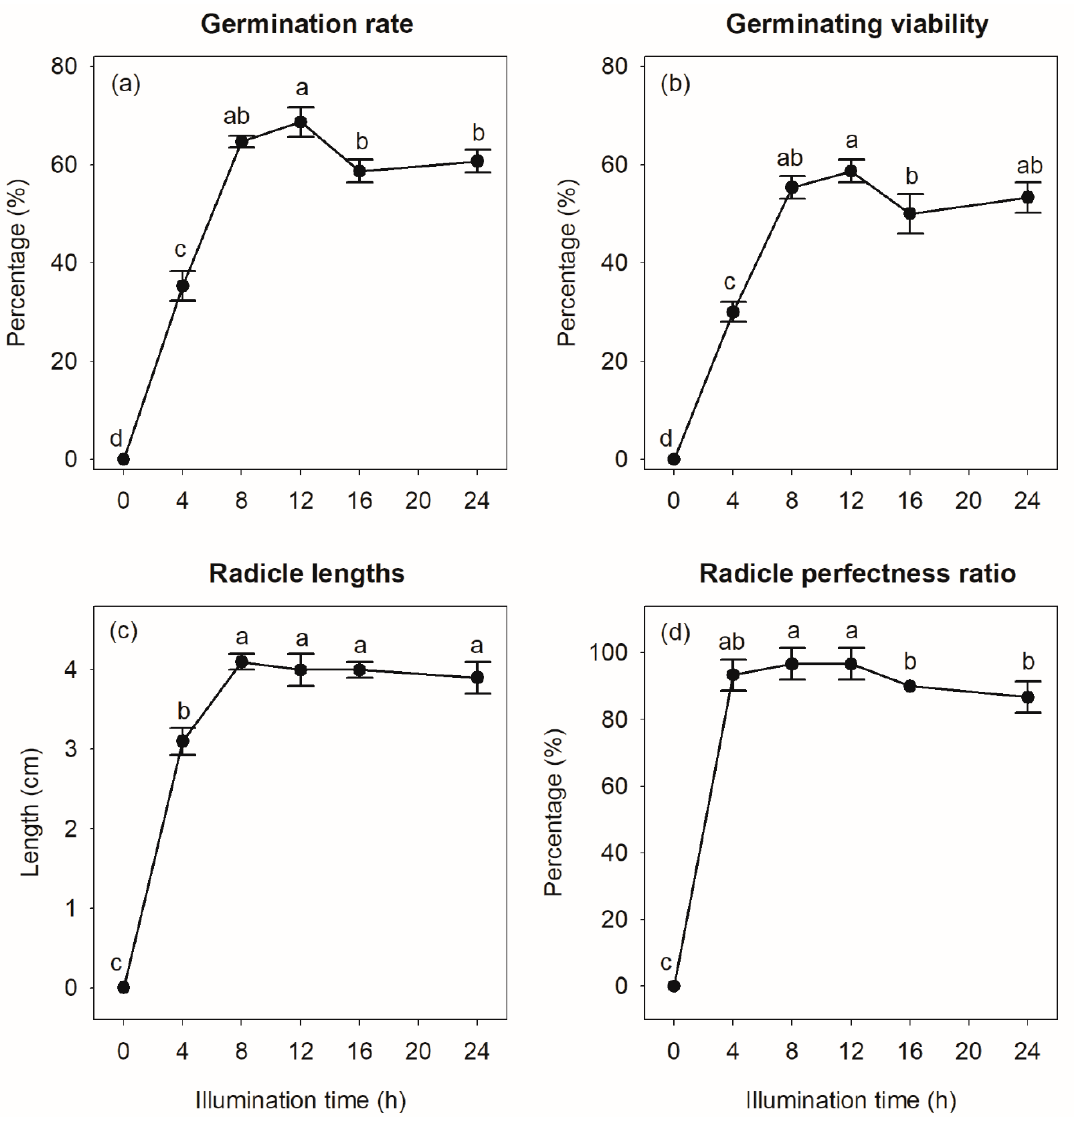
Figure 3. E ff ects of di ff erent illumination times on indicators. Di ff erent letters indicate significant Figure 3. Effects of different illumination times on indicators. Different letters indicate significant di ff erence ( p < difference ( p < 0.05).